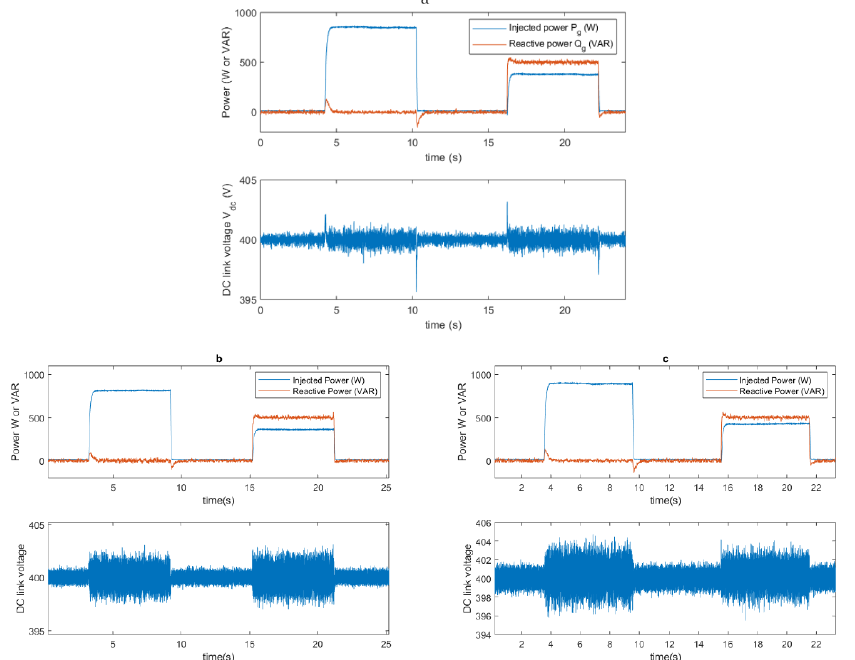
Figure 9. Response of the grid-side converter in the transient regime with the ( a ) linear controller, ( b ) SMC1 controller; and ( c ) SMC2 controller for C = 30 µ